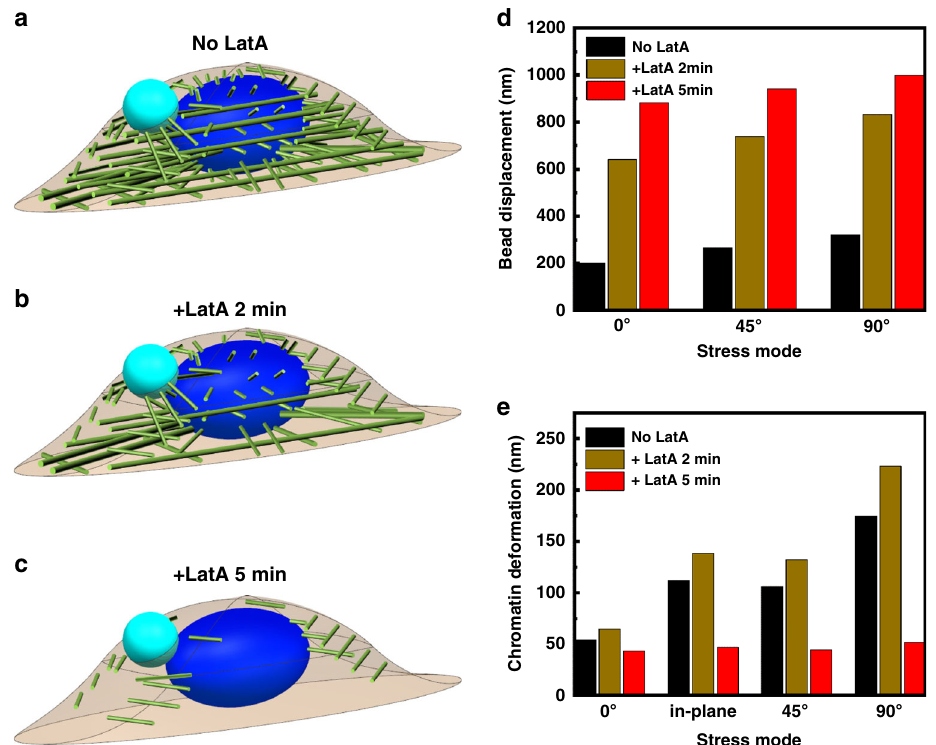
Fig. 6 FEM simulation of the effects of disrupting stress fi bers on cell and chromatin deformation. a No LatA control. b + LatA 2 min. c + LatA 5 min. Cell shapes and the bead are not drawn to scale. d Effects of the LatA treatment on magnetic bead displacements under different stress modes. e Effects of LatA treatment on chromatin deformation under different stress